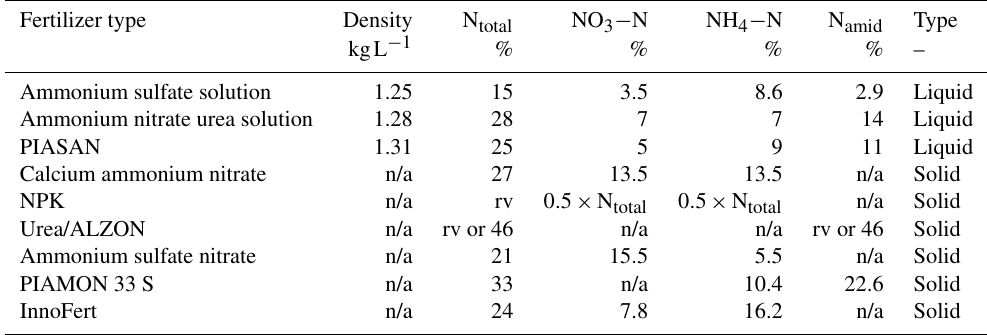
Table A1. Further information on the quantification rules to calculate the amount and type of mineral N from the reported applied mineral fertilizers on the 54 site years and the organic matter content.